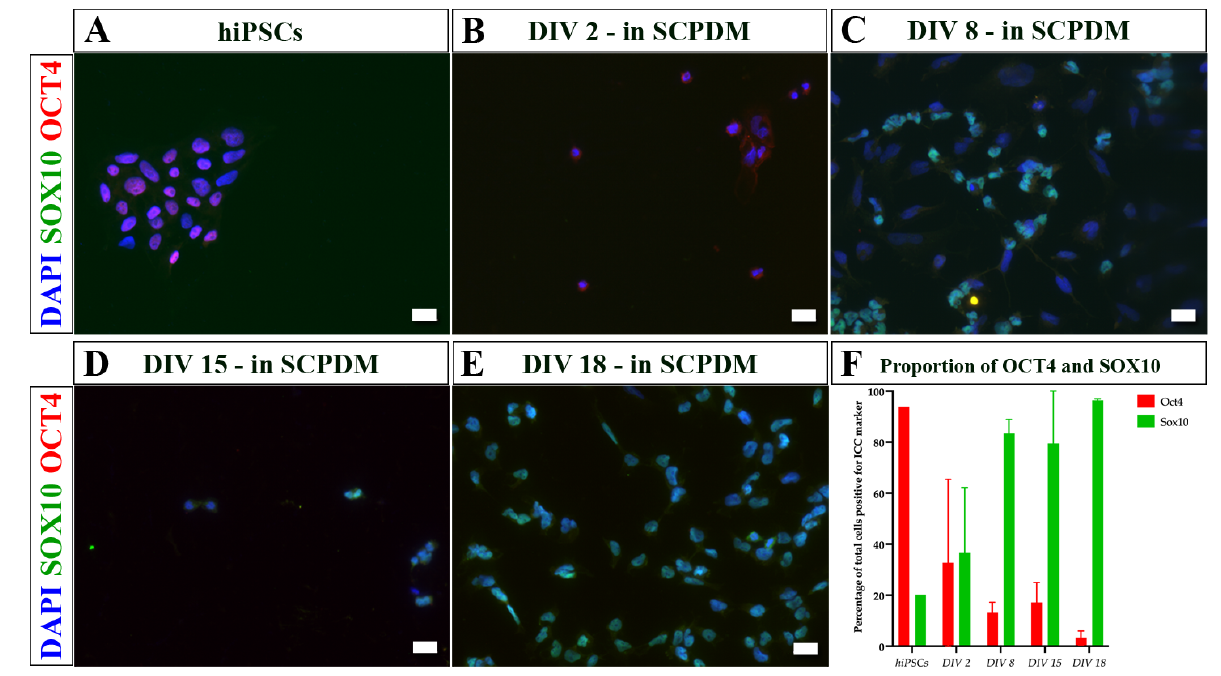
Figure 7. Immunocytochemistry images of ( A ) hiPSCs and ( B – E ) differentiating cells at different incubation times in antibiotic free SCPDM. ( B ) DIV 2, ( C ) DIV 8, ( D ) DIV 15, and ( E ) DIV 18. Cell nuclei were stained with DAPI (blue). ( F ) Proportion of total cells positive for OCT4 and SOX10 over time in SCPDM from two differentiation inductions. SOX10 (a marker for the Schwann cell lineage) is shown in green, increasing in proportion of the population over time, while OCT4 (a marker for pluripotency) is shown in red, decreasing over time. Scale bar = 20 µm. SCPDM = Schwann cell precursor differentiation medium.